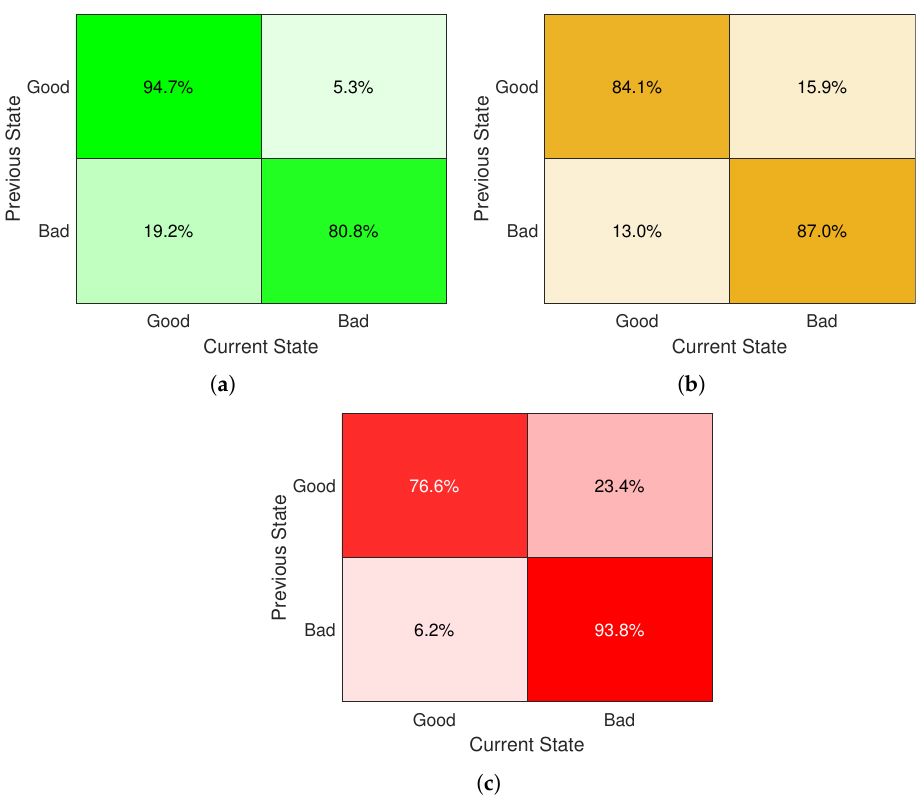
Figure 7. Examples of transition matrices for the two-state HMM: transition matrix P of the links from node 4 to node 2 observed in topology 2 ( a ), from node 3 to node 2 observed in topology 2 ( b ), and from node 1 to node 3 observed in topology 1 ( c